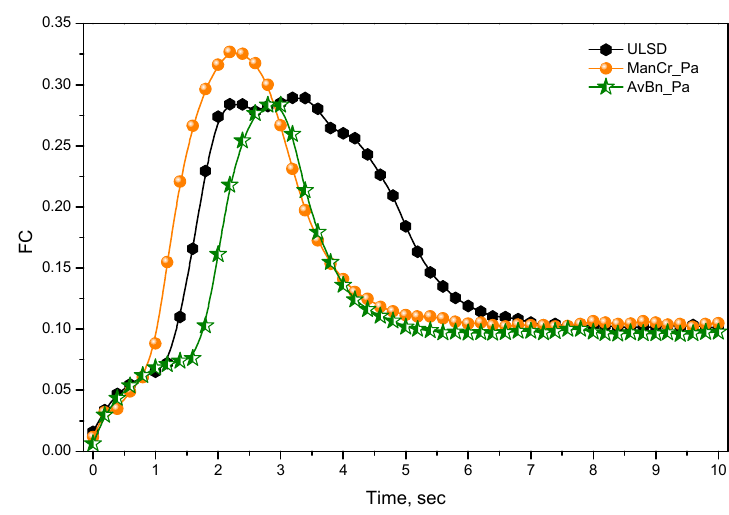
Figure 2. Variation of friction coefficient (FC) with time during the run-in period.